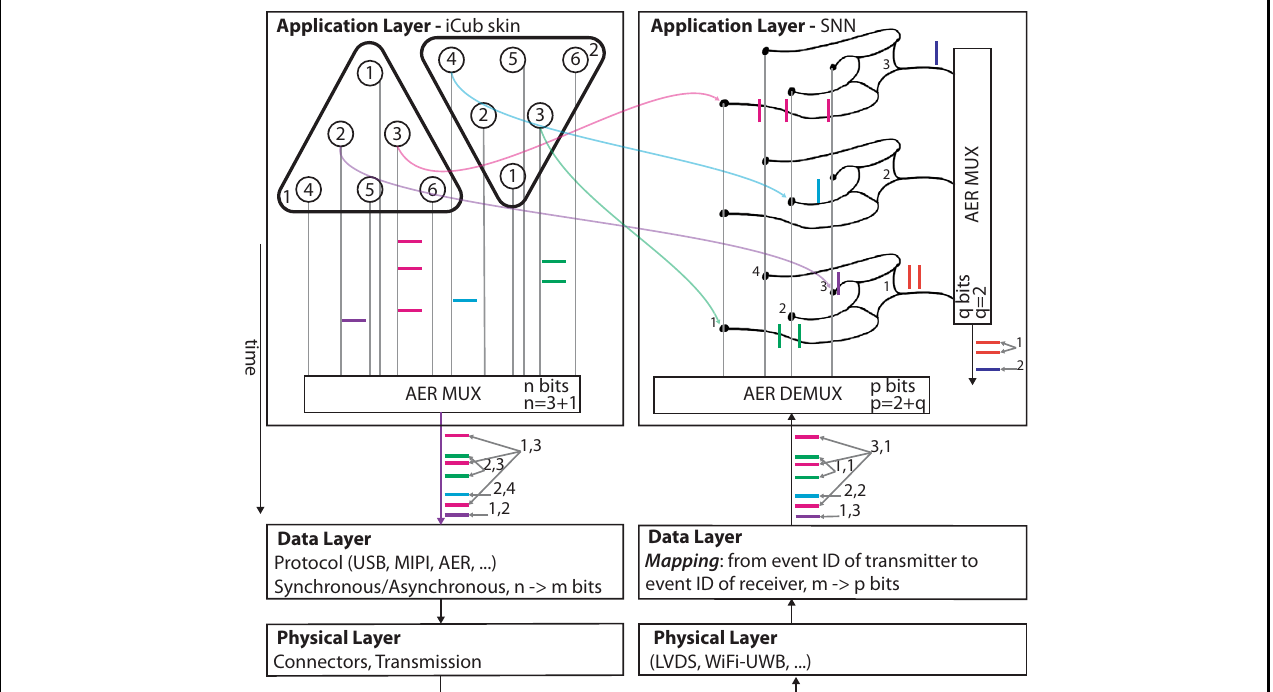
Fig. 3 AER: example of communication between an event-driven sensor (triangular skin patches, each with 6 sensing areas) and a spiking neural network (SNN) chip. Each sensing element emits asynchronous spikes that are sent to a bus through arbitration. The same are de-multiplexed to be sent to the correct synapse of the SNN